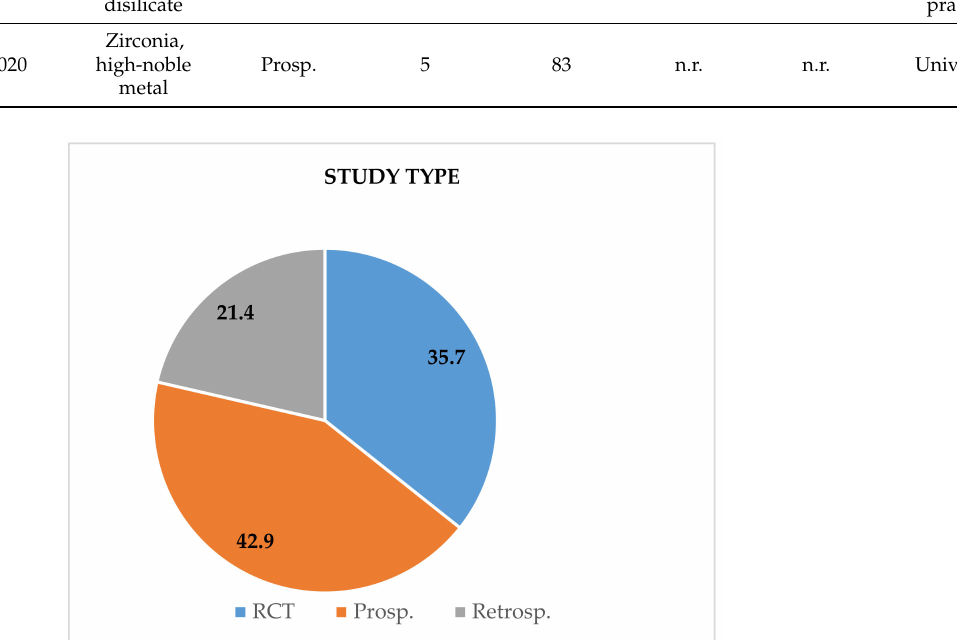
Figure 3. Types of the evaluated studies (RCT- Randomized control trial; Prosp- Prospective longitu- dinal study; Retrosp-Retrospective longitudinal